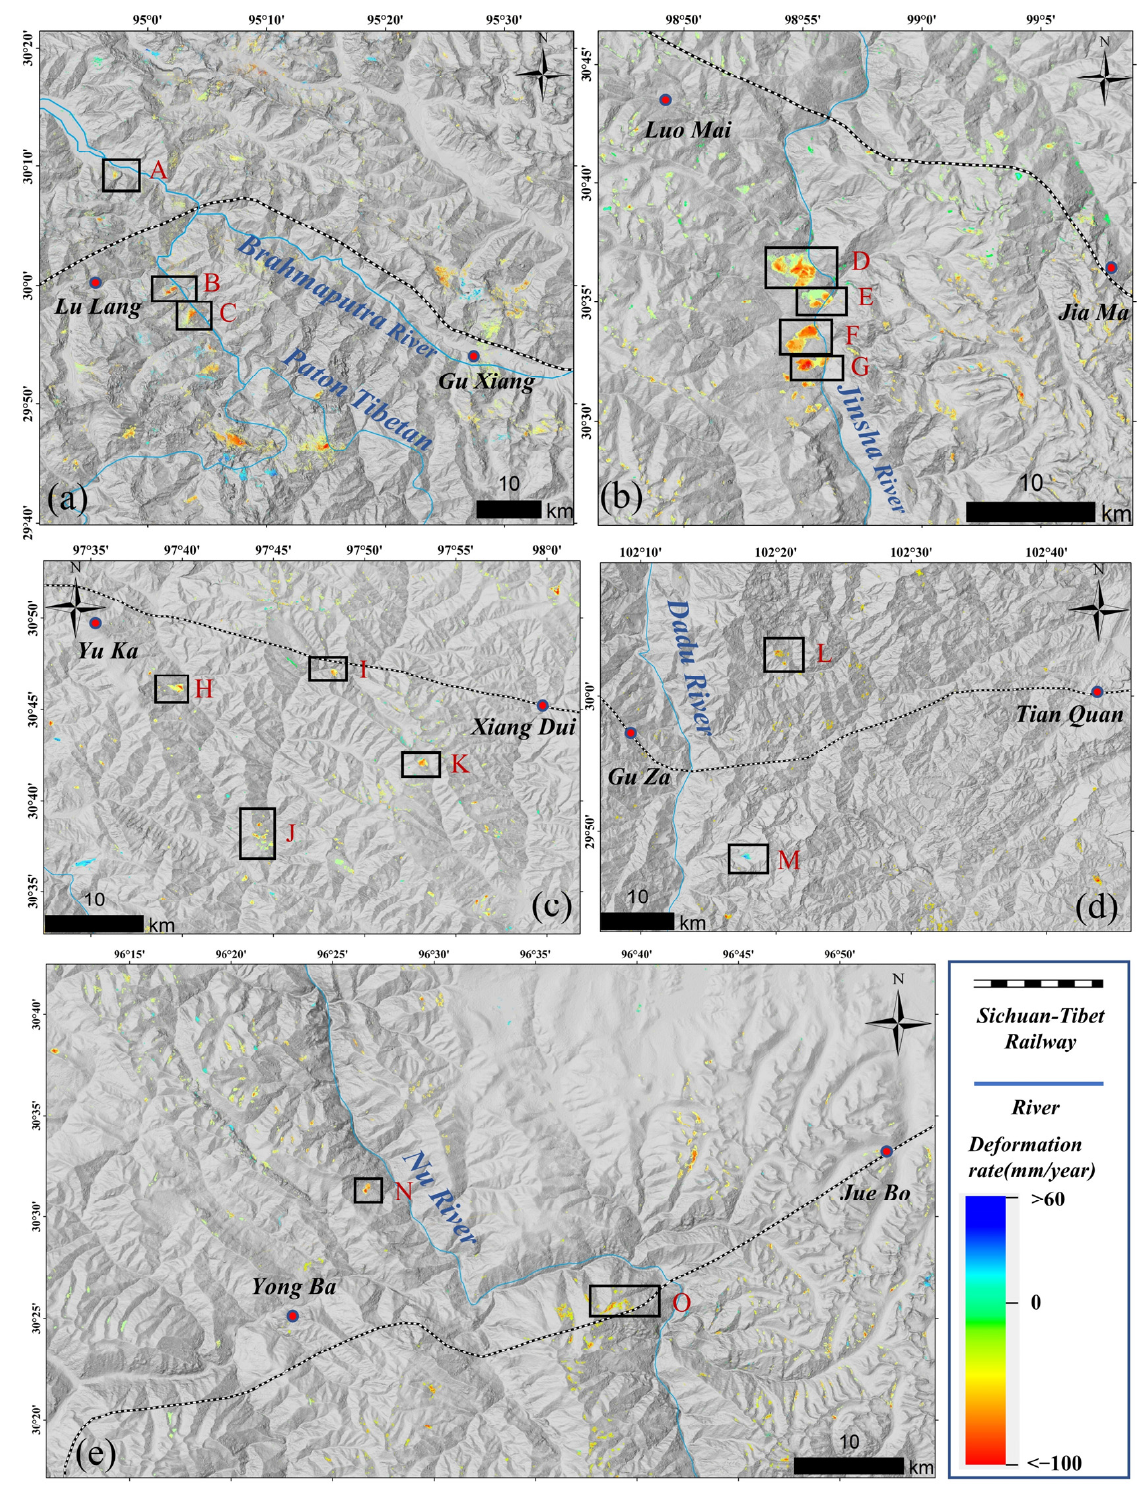
Figure 6. Hot spot analysis results of key regions. ( a ) Lulang–Guxiang section, ( b ) Luomai–Jiama section, ( c ) Yuka–Xiangdui section, ( d ) Guza–Tianquan section, and ( e ) Yongba–Juebo section, corresponding to zones 1–5 in Figure 5, respec- tively.